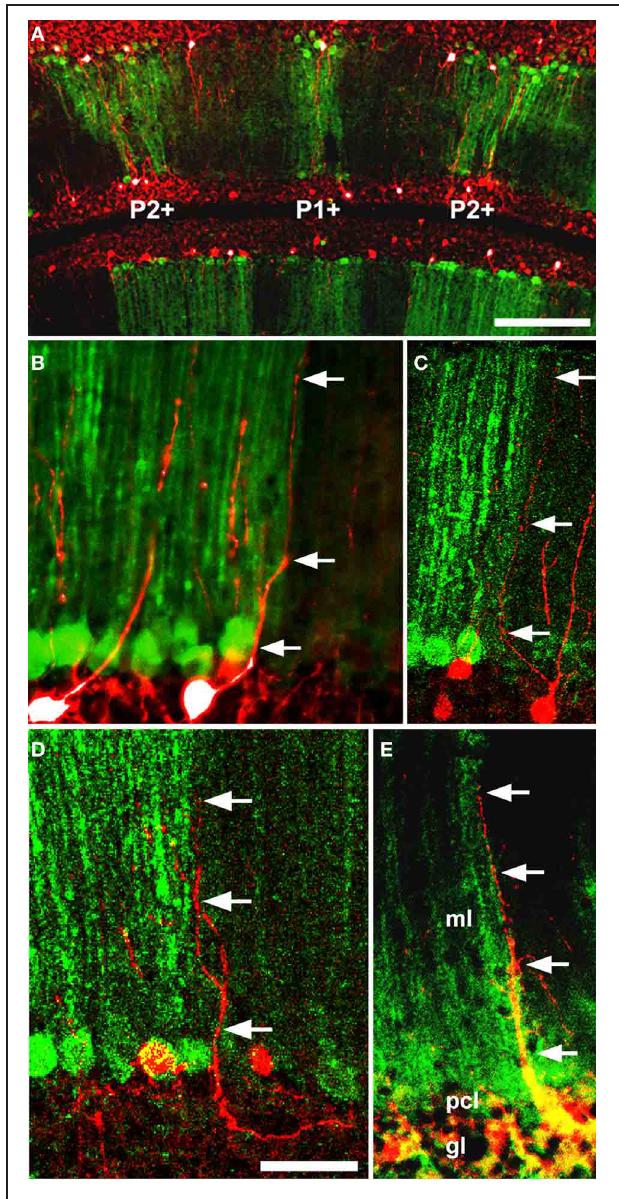
FIGURE 6 | Five examples (A–E) of double immunofluorescence for a GlyT2-EGFP transgene (Golgi cell dendrites: Zeilhofer et al., 2005) and anti-PLC β 4 (PC stripes: Sarna et al., 2006) in the adult mouse cerebellum reveals that Golgi cell dendrites are restricted at Purkinje cell stripe boundaries. Two examples of GlyT2-EGFP + Golgi cell dendrites (green: arrowheads) in the vicinity of a PLC β 4 + / − stripe boundary (red): in 68 cases examined, the dendrite never crossed between stripes. Abbreviations: ml, molecular layer; pcl, Purkinje cell layer; gl, granular layer. Scale bar = 50 μ m [From Sillitoe et al.